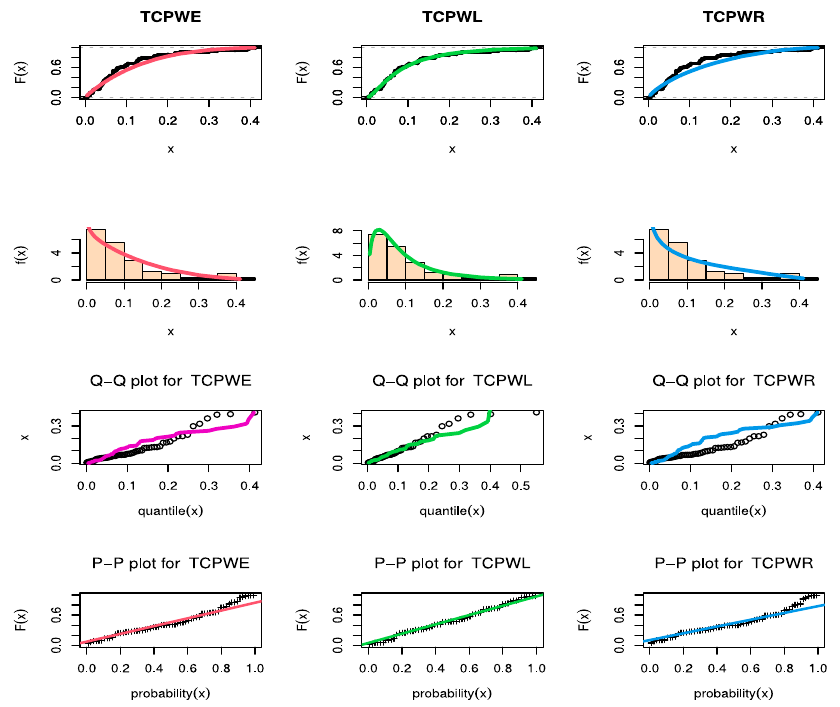
Figure 11. The estimated CDF, fitted PDF, PP-plot, and QQ-plot of the TCPWE, TCPWL, and TCPWR distributions for COVID-19 data.